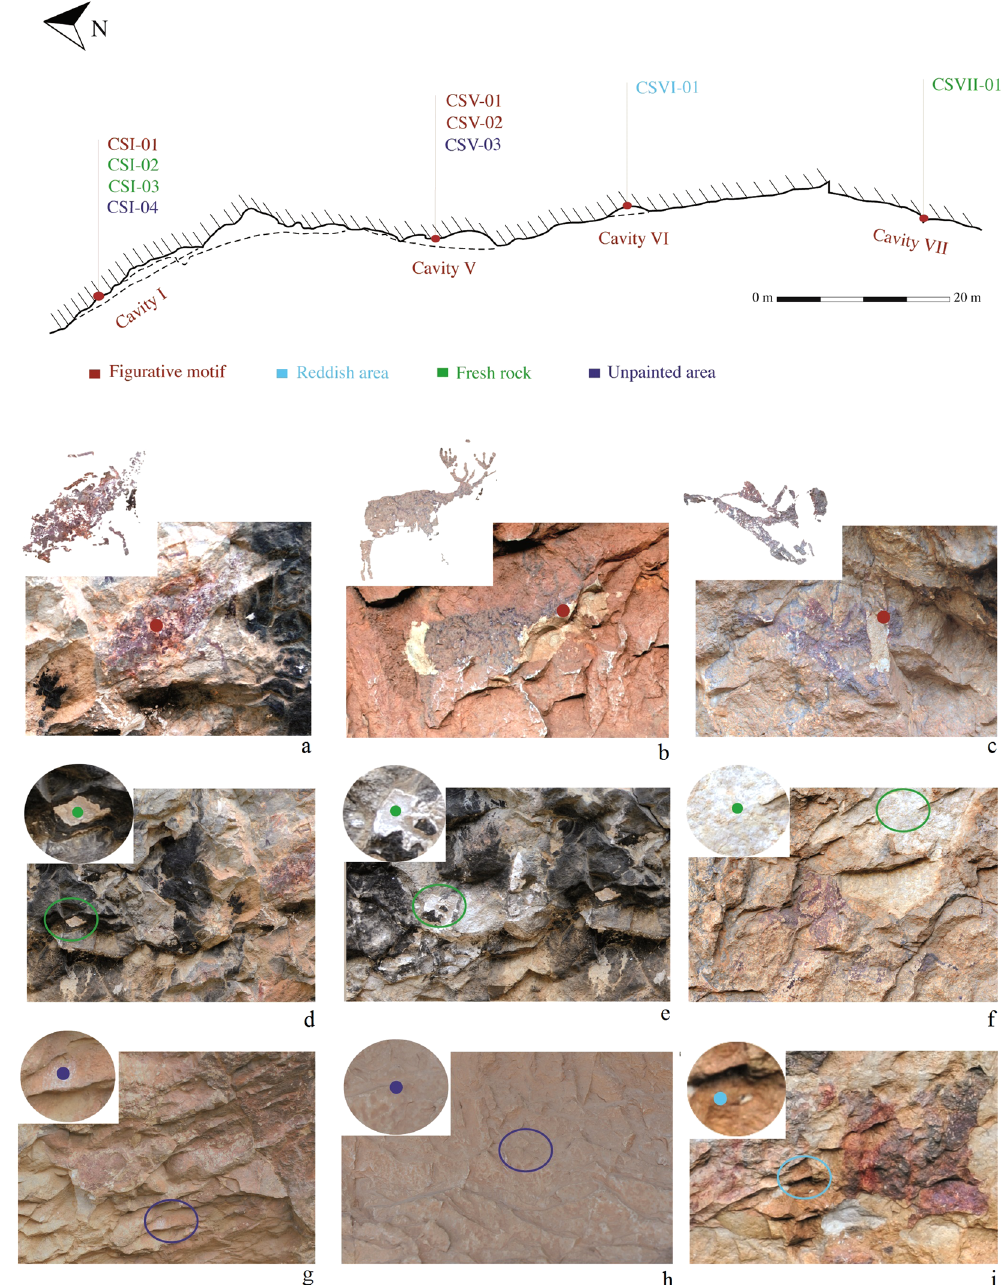
Figure 2. Floor plan of the Northern shelters of La Saltadora showing the distribution of the sampled figures and the control points. ( a ) Male goat (CSI-01). ( b ) Deer (CSV-01). ( c ) Archer (CSV-02). ( d ) Fresh rock (CSI-02). ( e ) Fresh rock (CSI-03). ( f ) Fresh rock (CSVII-01). ( g ) Unpainted area (CSI-04). ( h ) Unpainted area (CSV-03). ( i ) Reddish area